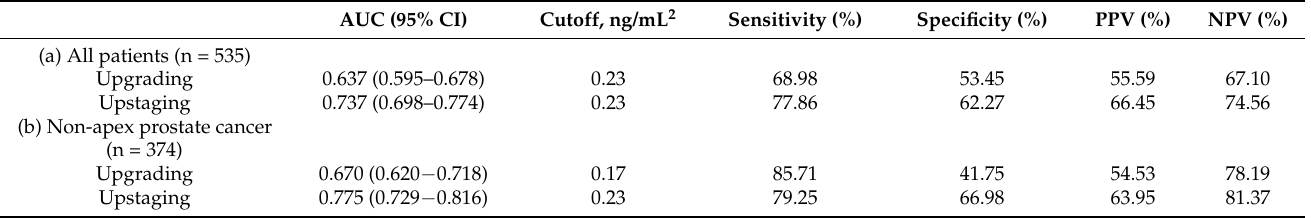
Table 4. The predictive characteristics of PSAD for predicting upgrading and upstaging. AUC (95% CI) Cutoff, ng/mL 2 Sensitivity (%) Specificity (%) PPV (%) NPV